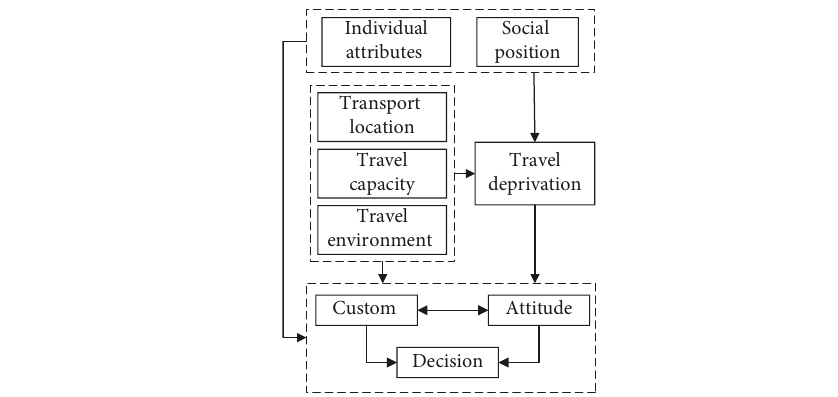
Figure 3: Conceptual model of travel decision-making of residents traveling to the urban center from the rapidly urbanizing Table 2: Results of measurement of the sense of travel deprivation.